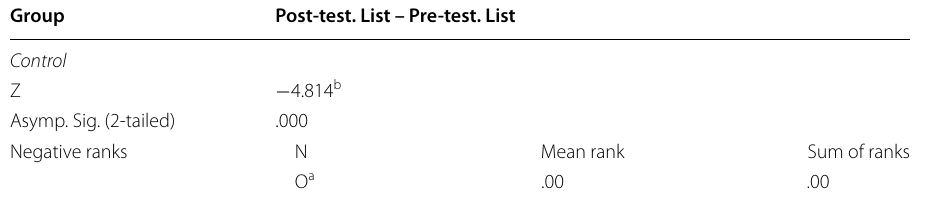
Table 7 Wilcoxon Signed Ranks Test Results